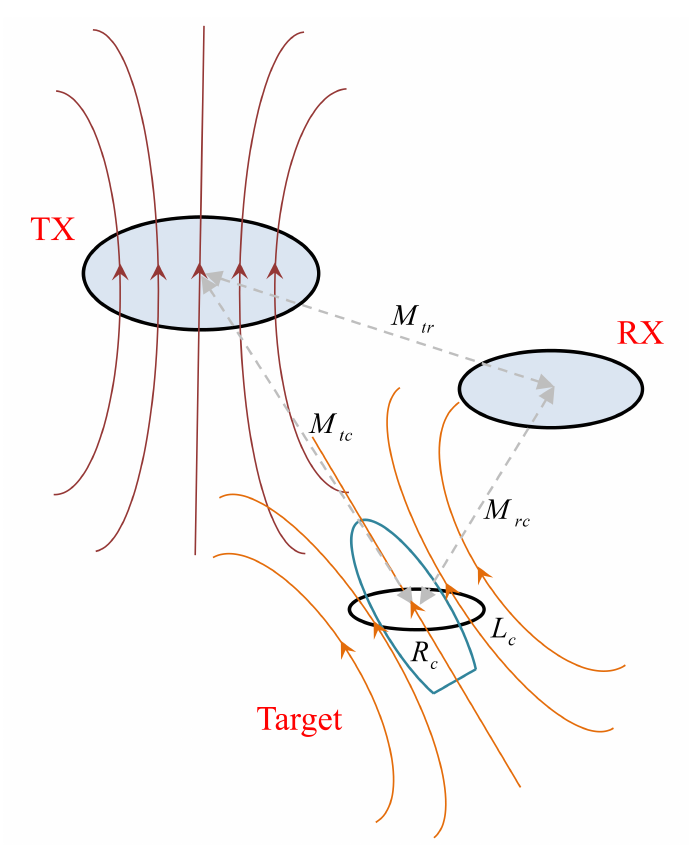
Figure 3. Coupling relationship diagram of the equivalent coil